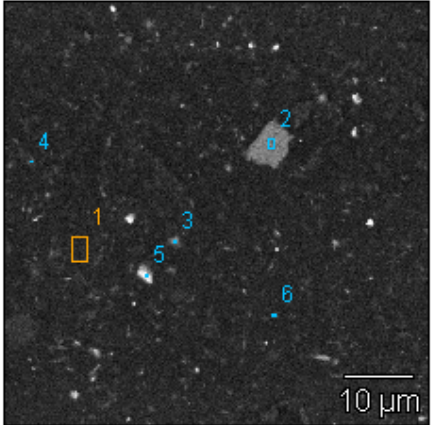
Figure 9. Examples of area selected to EDS examination, point 1: Areas free of attack, 2: Contamination of biomass with elements from the storage environment, 3–6: Areas attacked by microorganisms with barium and other metals presence.